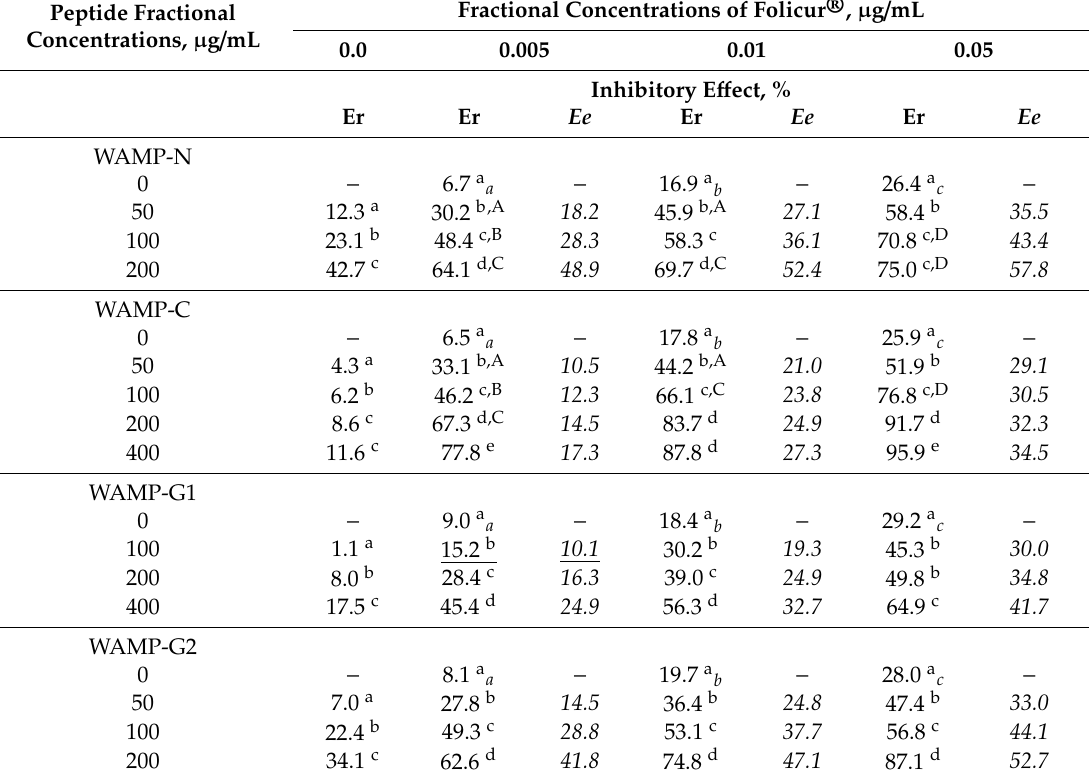
Table 2. Observed inhibitory e ff ects on conidial germination of F. oxysporum by Folicur ® EC 250 combined with the synthesized peptides (Er) at di ff erent fractional concentrations of the components. Er values are compared to the calculated inhibition levels expected if the inhibition was additive (Ee)